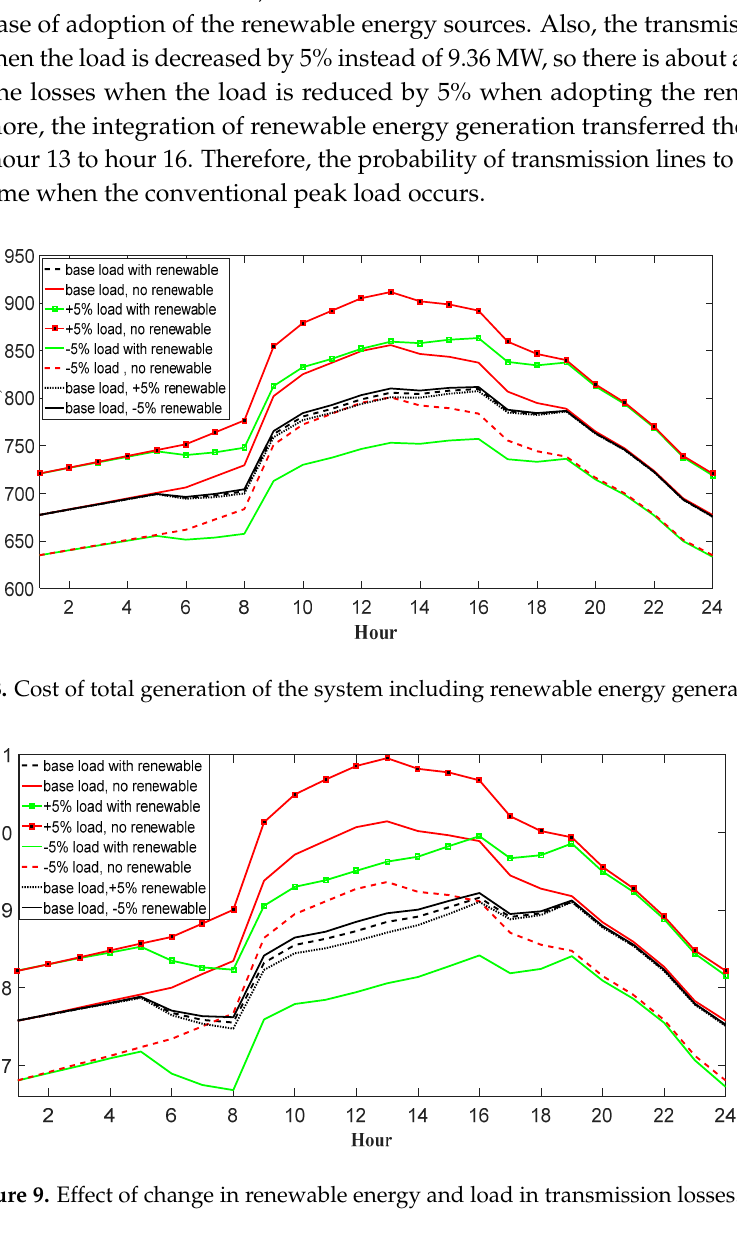
Figure 10. Effect of changing solar PV efficiency on total cost.